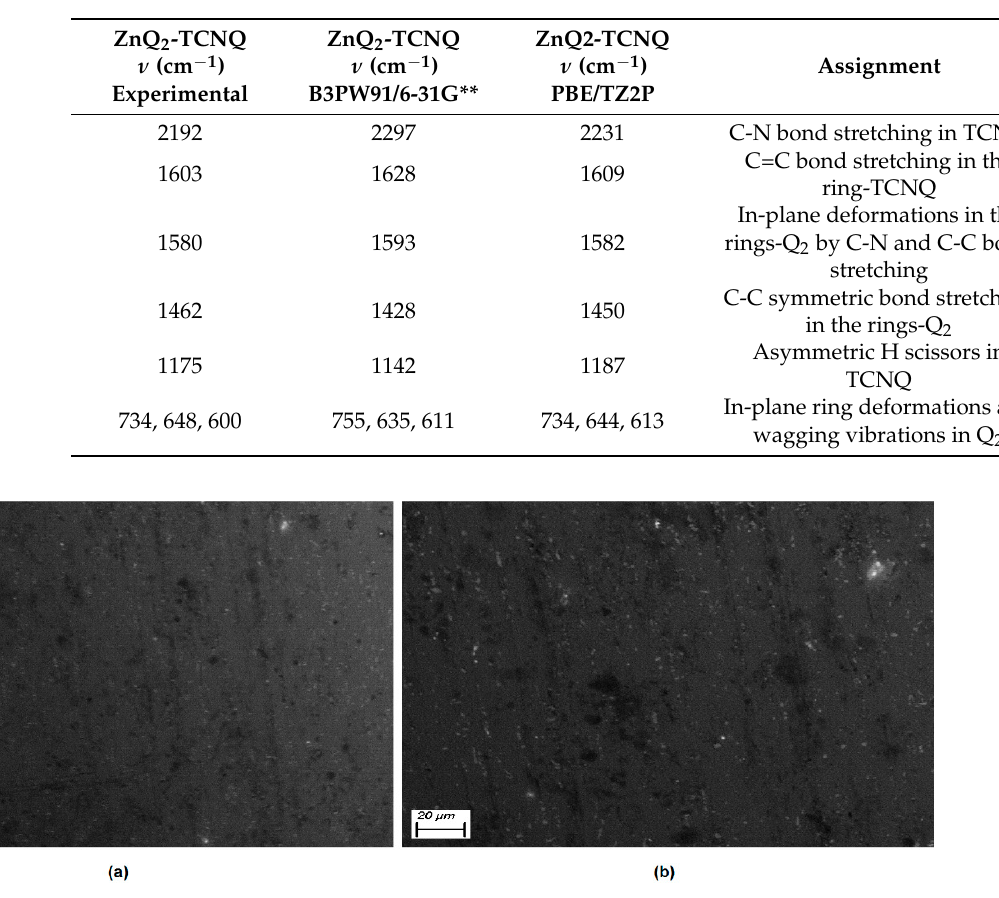
Table 2. Experimental and calculated IR frequencies and their assignment for ZnQ 2 -TCNQ.